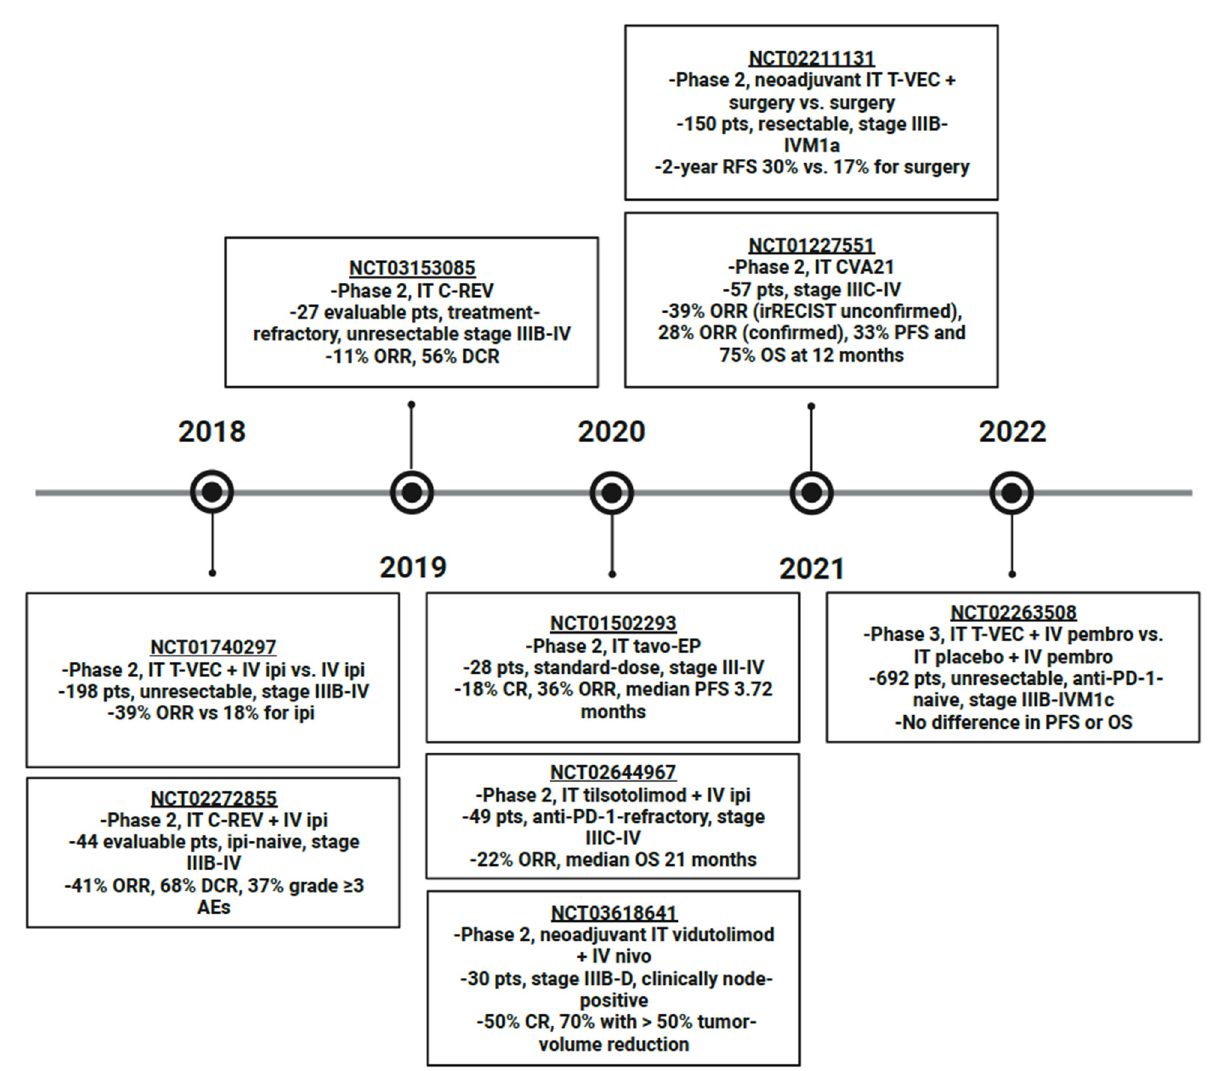
Figure 1. Timeline of Phase 2 or later clinical trials of intralesional therapy for advanced melanoma published in the last 5 years. Abbreviations: IT, intratumoral; IV, intravenous; T-VEC, talimogene laherparepvec; ipi, ipilimumab; pts, patients; ORR, overall response rate; C-REV, canerpaturev; DCR, disease control rate; AE, adverse event; tavo-EP, tavokinogene telseplasmid electroporation; CR, complete response; PFS, progression-free survival; PD-1, programmed cell death protein 1; OS, overall survival; nivo, nivolumab; RFS, recurrence-free survival; CVA21, coxsackievirus A21; irRECIST, immune-related response evaluation criteria in solid tumors; pembro, pembrolizumab.